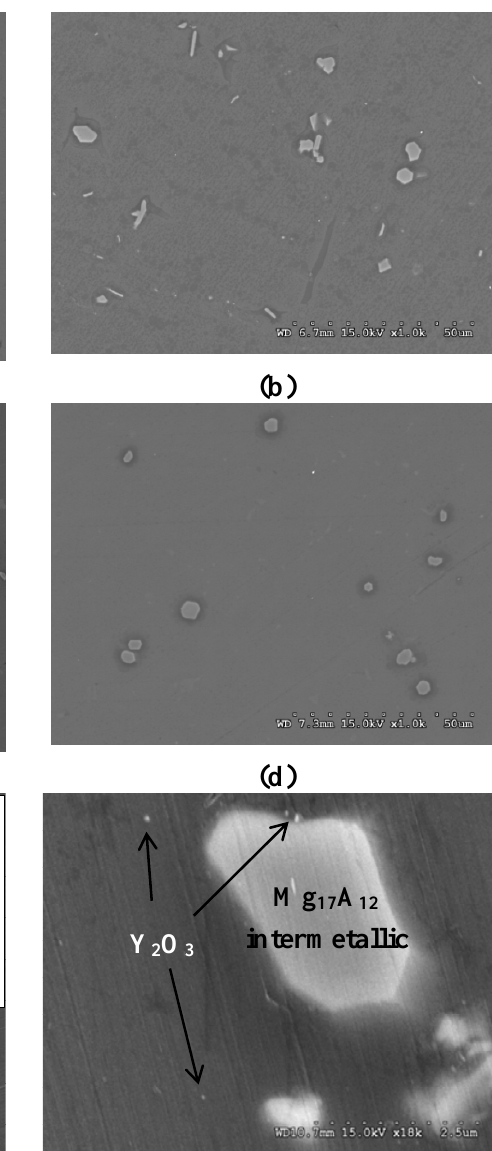
O composite; 2 3